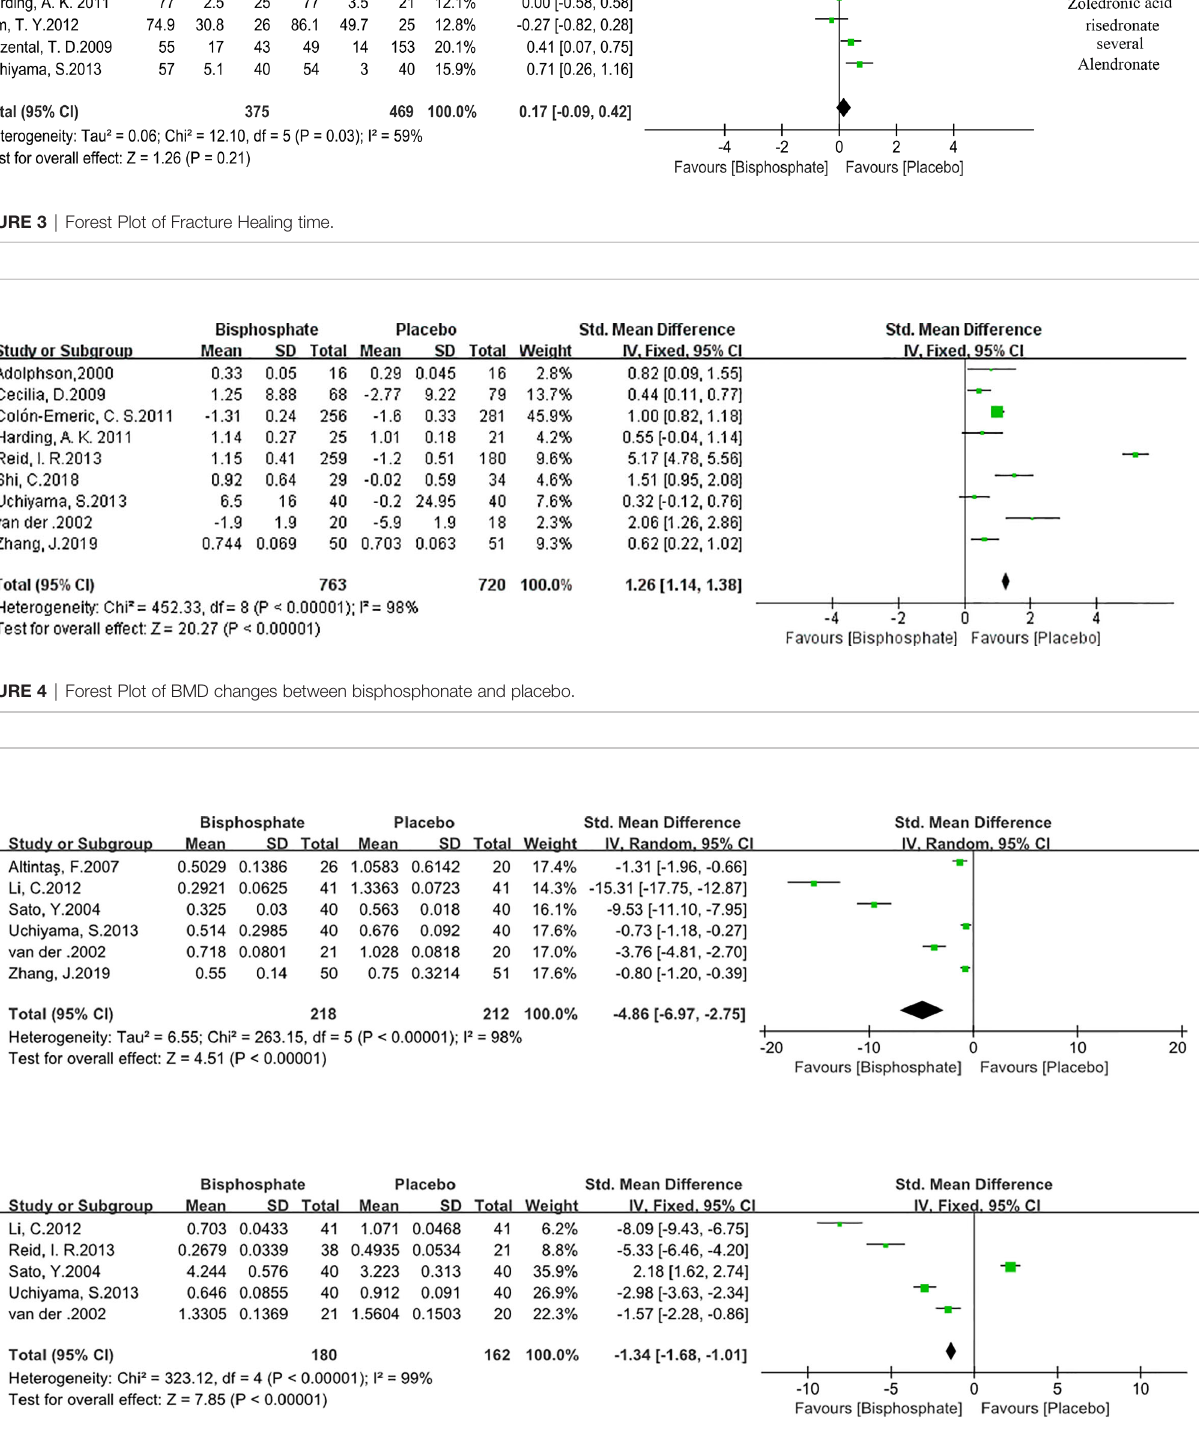
FIGURE 5 | Forest Plot of Bone Turnover Markers (A) . Bone resorption biomarker. (B) . Bone formation